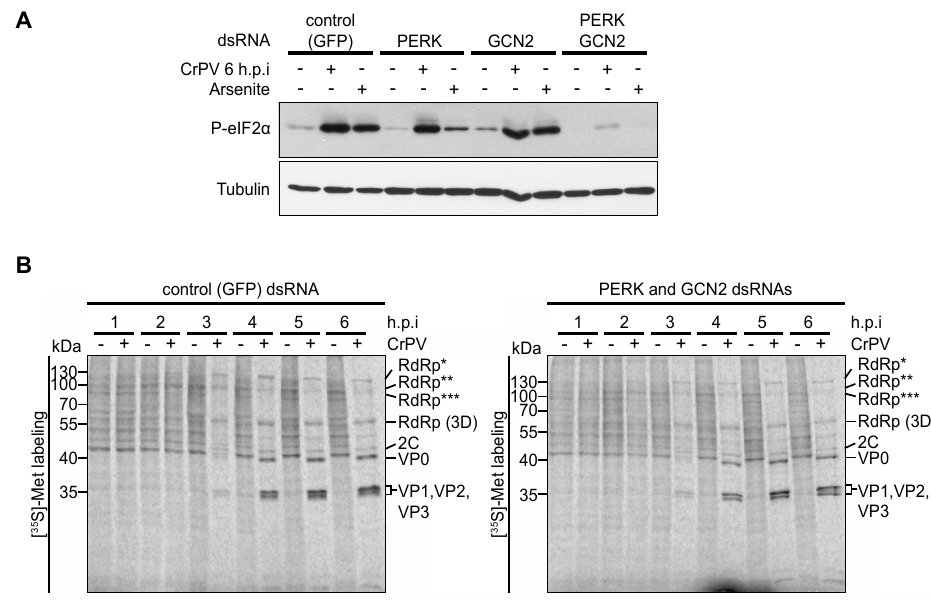
Figure 5. Role of dPERK and dGCN2 eIF2 α kinases in CrPV-infected S2 cells. ( A ) Immunoblots (anti-phospho-eIF2 α (P-eIF2 α ) and anti-Tubulin antibodies) of lysates from cells treated with control (GFP) dsRNAs or singly dPERK or dGCN2 dsRNAs or both dPERK/dGCN2 dsRNAs for 48 h followed by arsenite (500 µM) treatment or infection with CrPV (MOI 10); ( B ) [ 35 S]-Met/Cys pulse-labelled protein lysates from control or dPERK and dGCN2 dsRNA-treated S2 cells that were either mock or CrPV-infected (MOI 10) for the indicted times (h.p.i.) were resolved on a 12% SDS-PAGE gel. Shown are representative autoradiographs from at least three independent experiments. RdRp*, RdRp**, and RdRp*** denote polyproteins containing RdRp at the approximate sizes of 120 kDa, 105 kDa, and 100 kDa, respectively.